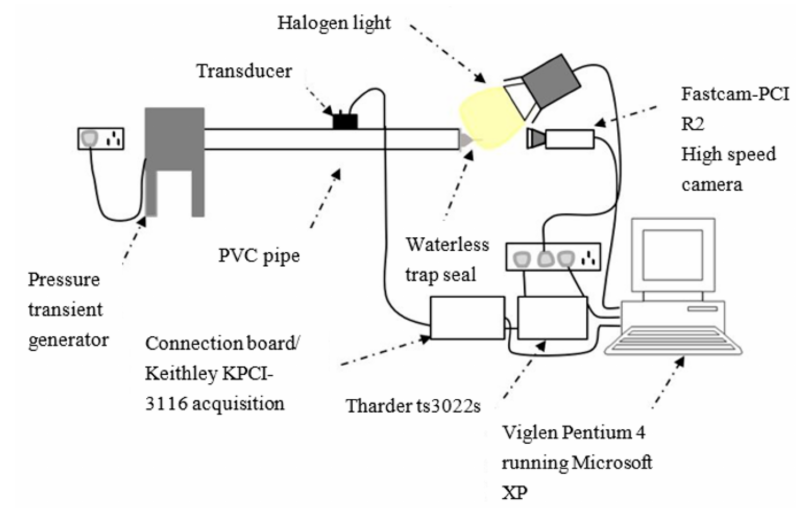
Figure 2. Laboratory setup for the monitoring of the trap seal response.